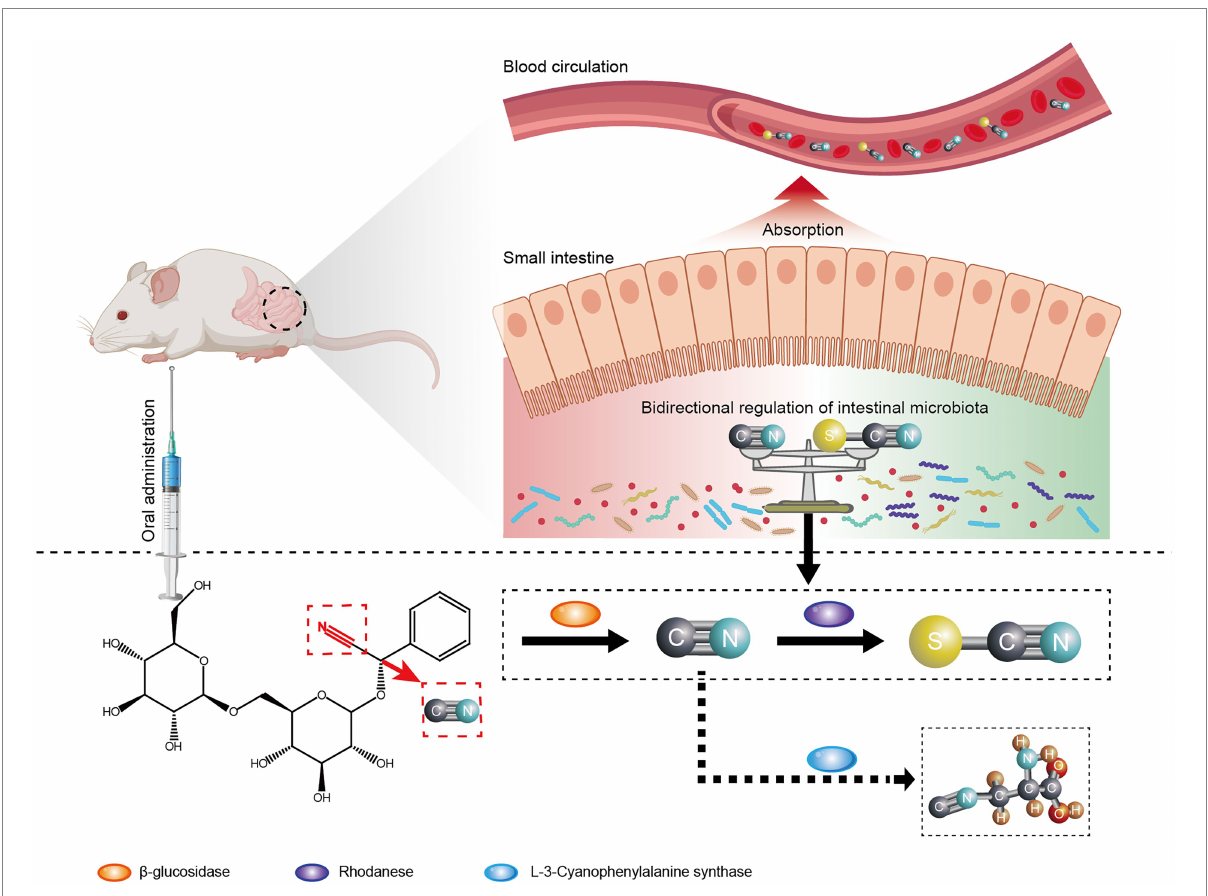
FIGURE 10 Diagram showing the role of intestinal microbiota on the regulation of toxicity and detoxification mechanisms of